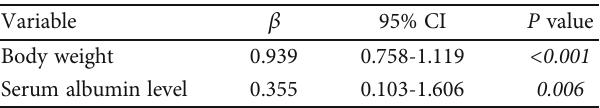
Table 5: Factors a ff ecting skeletal muscle mass index in patients with